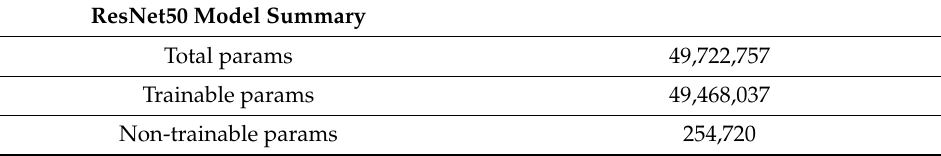
Table 4. ResNet50 model summary.